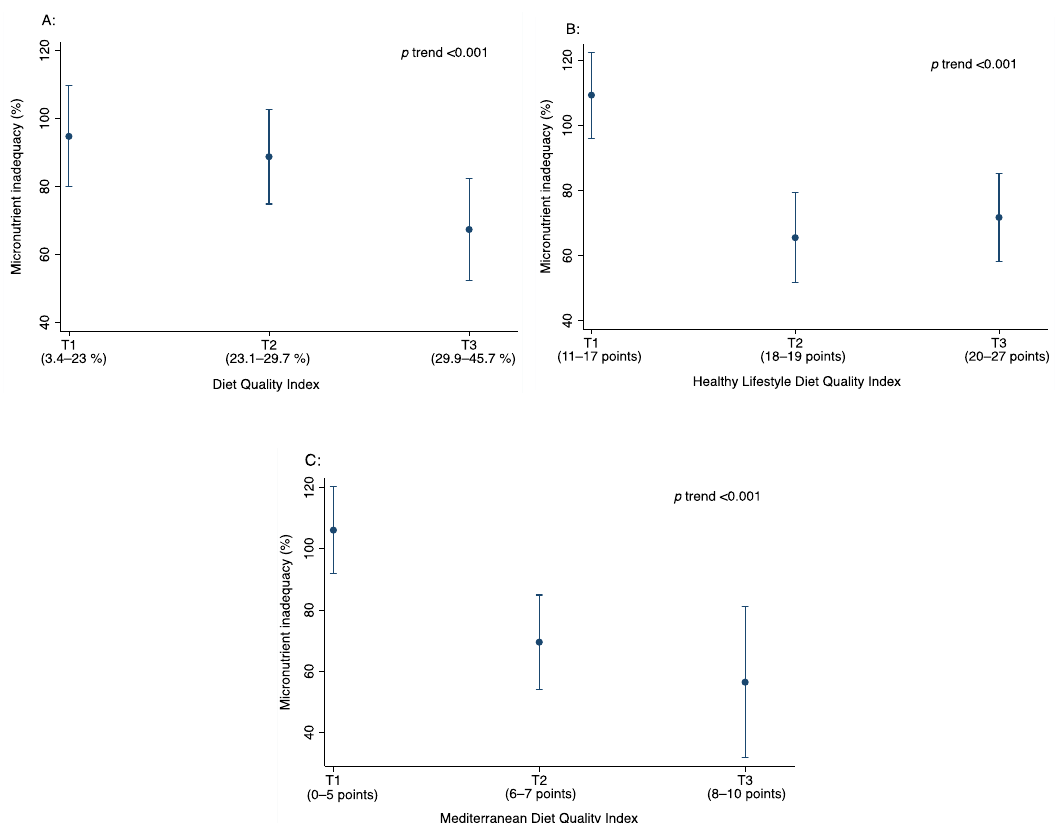
Figure 2. Micronutrient inadequacy (%) across the tertiles (T) of Diet Quality Index ( A ), Healthy Lifestyle Diet Index ( B ) and Mediterranean Diet Quality ( C ) at baseline in children with abdominal obe-